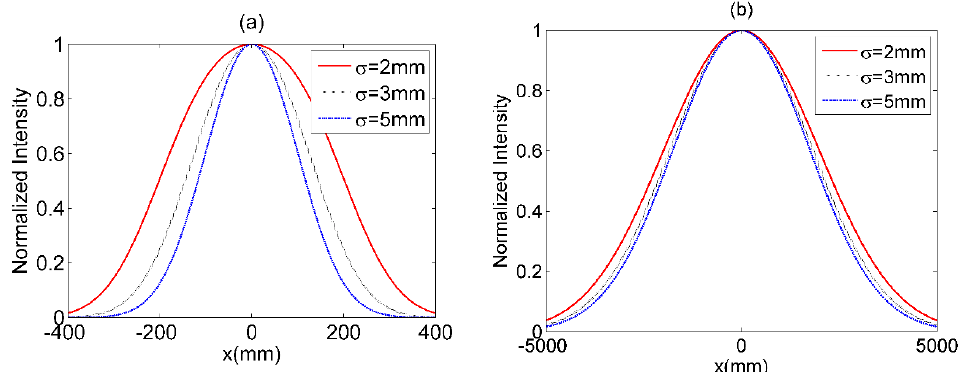
Figure 5. The cross sections of N × D MGSM array beam with N = D = 3, propagating through non- Kolmogorov turbulent atmosphere for σ . ( a ) z = 600 m and ( b ) z = 5000 m.